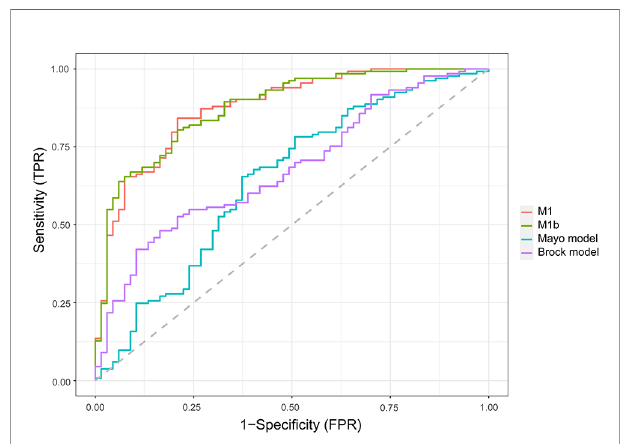
FIGURE 2 | Comparison of lung cancer prediction models in the validation cohort. Model discrimination is measured by area under the ROC curve. TPR , true-positive rate; FPR , false-positive rate.